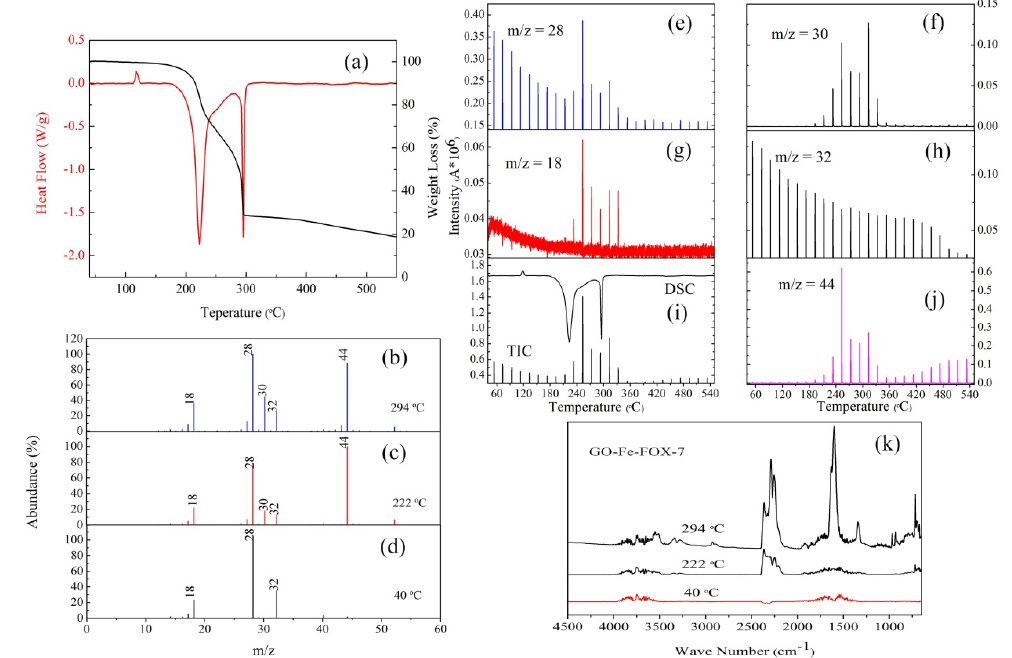
Figure 11. ( a ) DSC and TG curves of nGO-Fe-FOX-7 with heating rate of 10 °C/min; the MS spectra of nGO-Fe-FOX-7 at ( b ) 294 °C, ( c ) 222 °C and ( d ) 40 °C; the ion current spectra of nGO-Fe-FOX-7 in the decomposition with ( e ) m/z = 28, ( f ) m/z = 30, ( g ) m/z = 18, ( h ) m/z = 32, ( i ) total ion current, ( j ) m/z = 44; ( k ) IR spectra of nGO-Fe-FOX-7 at 294 °C, 222 °C and 40 °C.